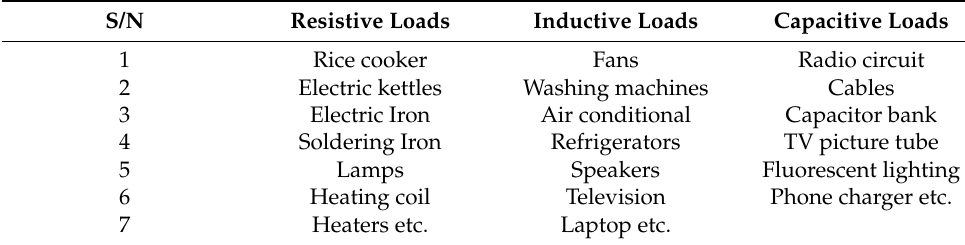
Table 2. Classes of loads with indoor broadband noise.